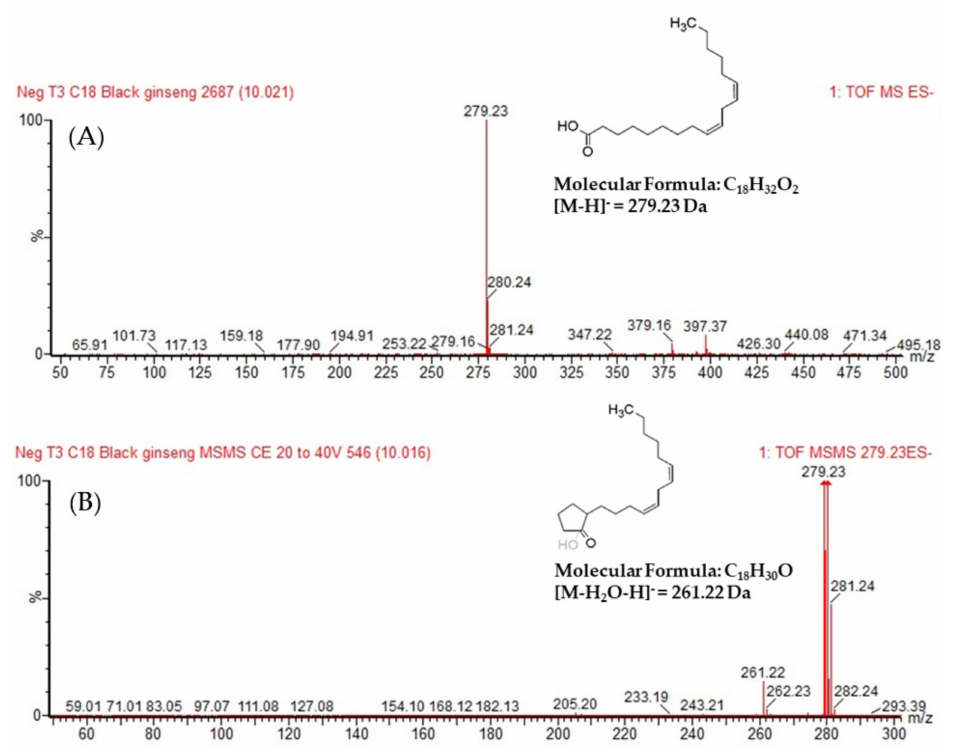
Figure 2. ( A ) The MS spectrum of the unknown peak with a significant difference, and ( B ) the magnified MS/MS spectrum obtained through fragmentation using collision-induced dissociation mode. The precursor ion ([M-H] = 279.23) was not fully fragmented. The most abundant fragment ion was [M-H] = 261.19. The structure of the fragment ion was predicted with MassFragment™